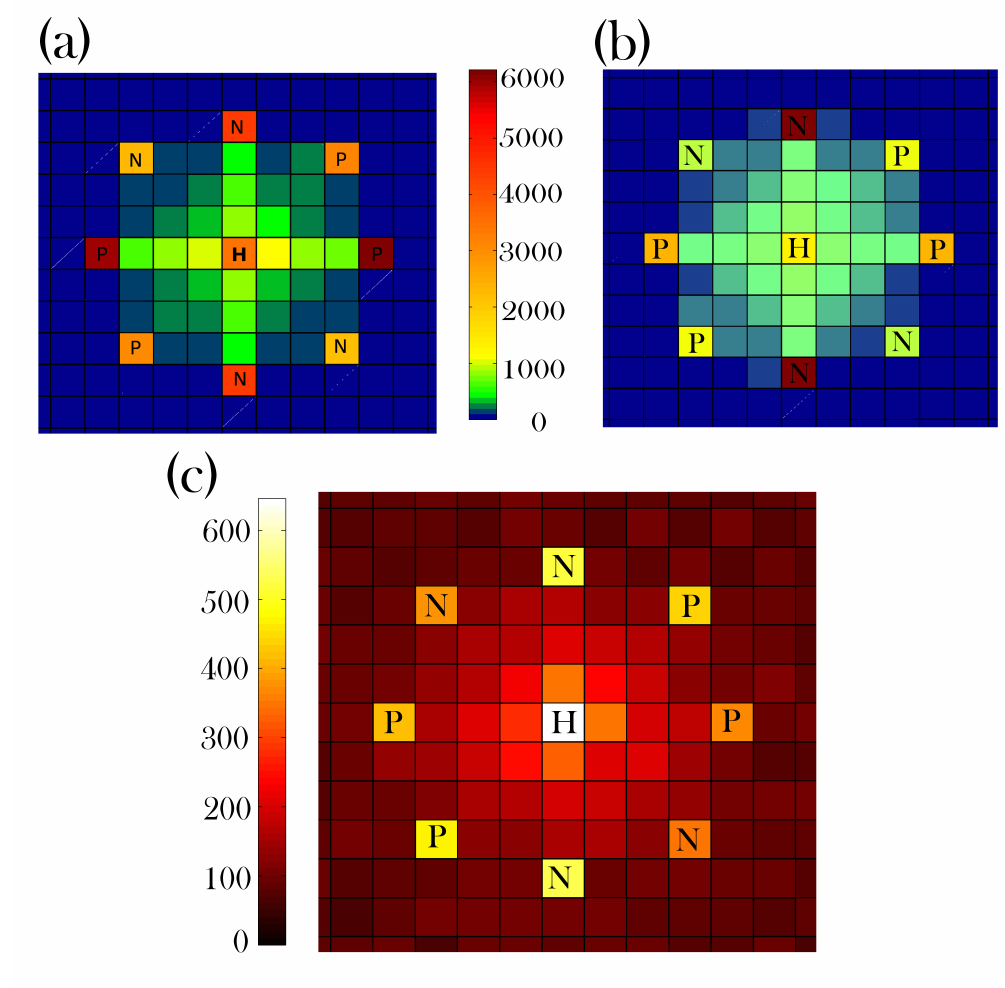
Figure 12. Number of dead foragers found in each patch of a 25 × 25 grid of 4m × 4m patches totalled between February and September. The total number of dead foragers in this time is 55,283, 55,592 and 56,426 in ( a – c ) respectively. The pollen and nectar sources (in patches labelled P and N, respectively) are assumed to be constant throughout the year. The hive itself is labelled H. The colour resolution is roughly 100 bees in Panels (( a , b ) and 10 bees in Panel ( c ). Panel (( a ) shows a simulation with no pesticide exposure but with normal navigation error ε = 0.1. In Panels ( b , c ). this navigation error is increased because of pesticide exposure to a maximum of 0.35 and 1.0, respectively. In Panel (( a ), there are fewer than 10 bees in each blue cell, and in Panel ( b ), there are between 10 and 30 bees in each blue cell. The effect of pesticide on the bees is cumulative. In early spring, there is less build up of toxins within individual bees and thus their navigation is better than it is in late